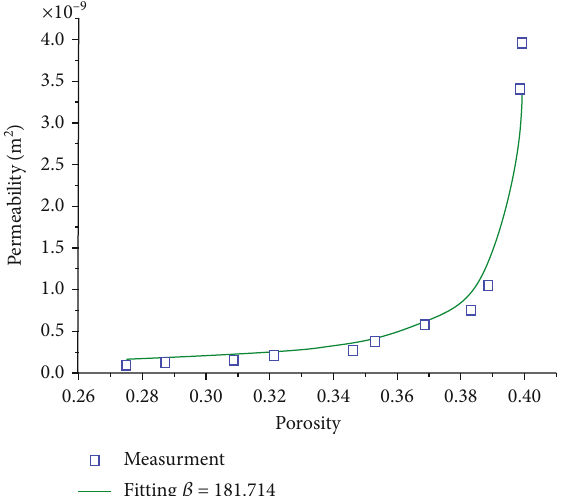
Figure 9: Relation of the permeability to the porosity.